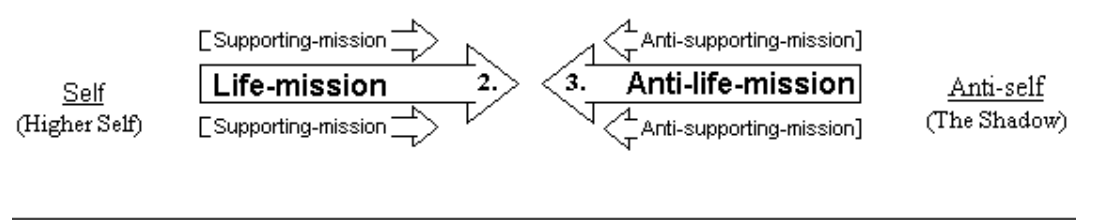
FIGURE 1. The life-mission, as well as all the supporting missions, is repressed, and man does not know himself. The repression has happened through negative anti-decisions, which outbalance the positive missions. The negative decisions are hence anti-self intentions that are organized around the most basic self-denial — the negative decisions that are here called anti-life–missions. All of these anti-self intentions exist in the parts of us that are still active, even though they are repressed; they sum up to be one self-destructive intentional structure in us, here called the anti-self.